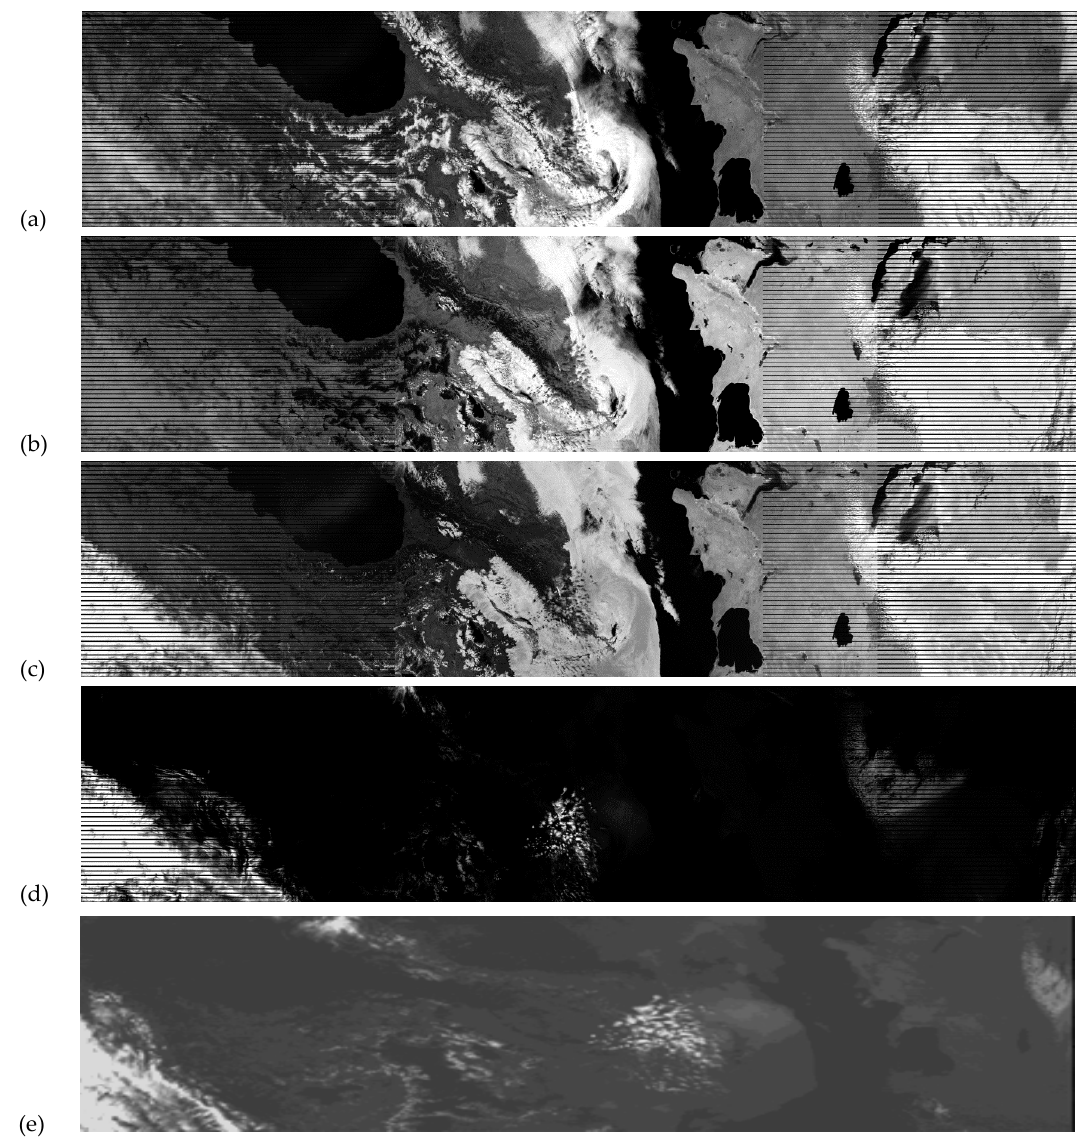
Figure 7. VIIRS imagery collected on 31 March 2013 at 0939 UTC as first shown in Figure 1. ( a ) shows the M7 (865 nm) band of the VIIRS granule shown in Figure 1a. Cloud, ice, and snow features are bright in this figure. Snow and ice are darker in the VIIRS M10 (1610 nm) band shown in ( b ), but poorer contrast is found between ice clouds (in the lower-left corner) and cloud-free land, especially when compared to the BTD M12-M13 (3700–4050 nm) image shown in ( c ). ( d ) shows VIIRS M9 (1378 nm) band where all surface features are dark; however, these cloud-free surfaces are visible in the corresponding MODIS 26 band (1375 nm), shown in ( e